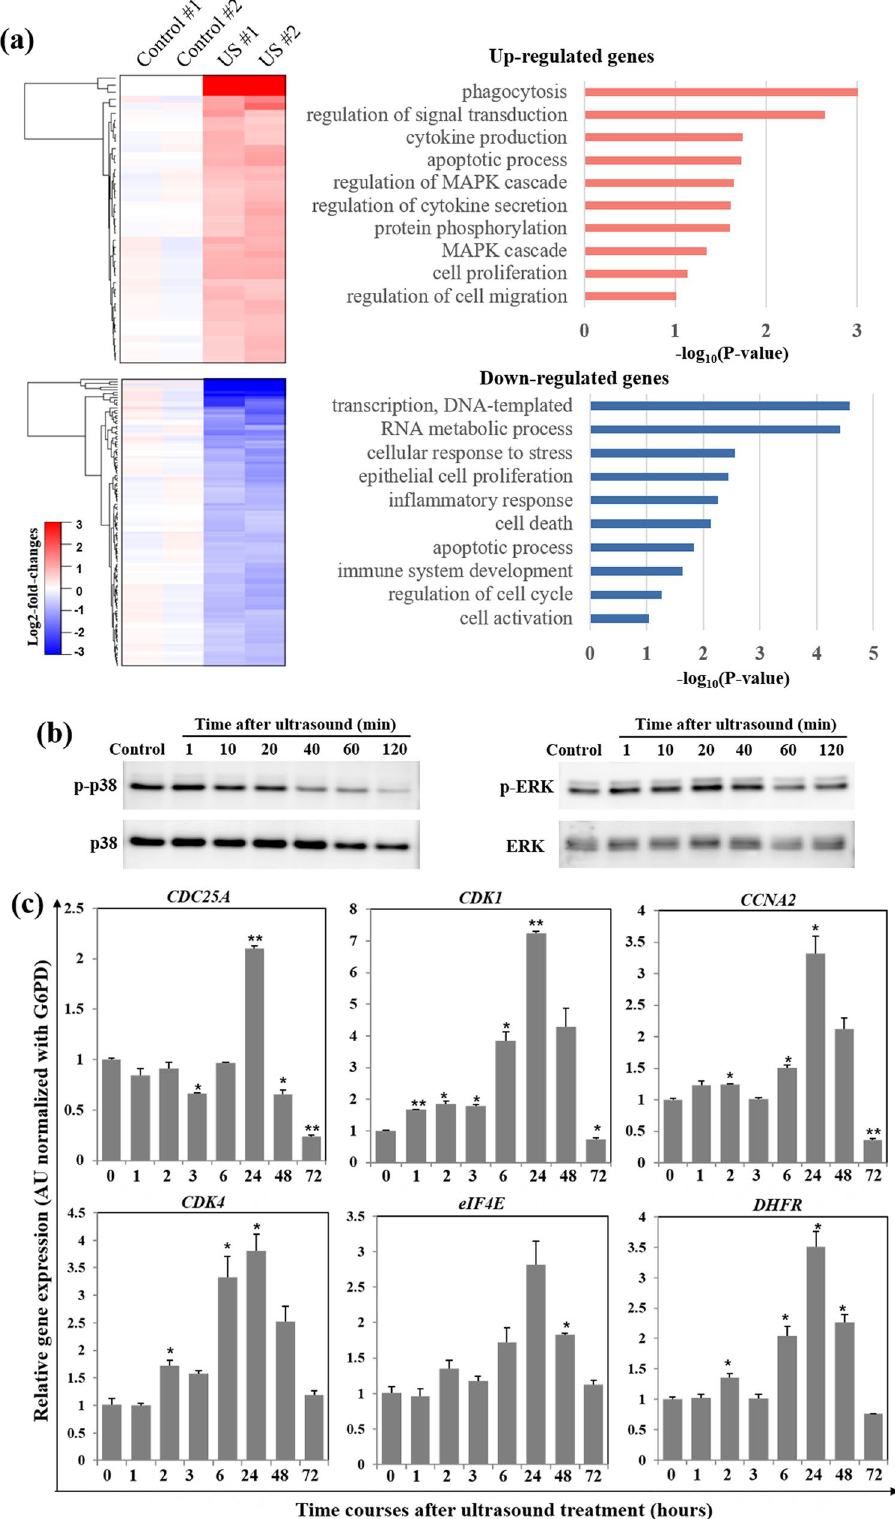
Figure 4. ( a ) Heat maps of upregulated and downregulated genes at 3 h post treatment with 12% ultrasound for 10 s. Differentially-expressed genes were identified using P < 0.05 and |log 2 -fold-change|> 0.326 as cut-off values. Biological processes associated with the upregulated (top) or downregulated (bottom) genes following ultrasound treatment. ( b ) Phosphorylated or total protein levels of p38 and ERK1/2 at the indicated time points (minutes) were determined by western blot analysis. Glucose-6-phosphate dehydrogenase (G6PD) was used for normalization. ( c ) The mRNA expression of cell proliferation-related genes was analyzed by qRT-PCR at the indicated time points (hours). * P < 0.05 and ** P < 0.005 compared with the level in the control